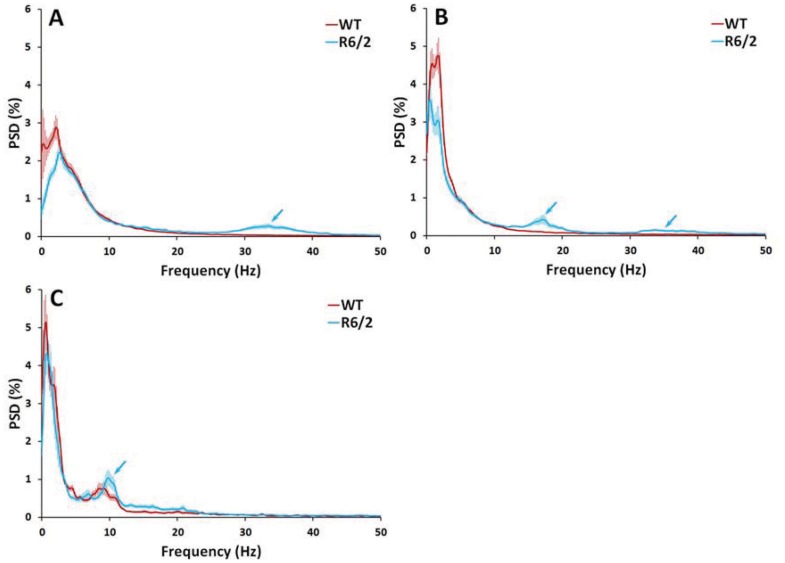
Striatal PSD across the different behaviors.Mean PSD curves obtained from striatal LFPs are denoted as a proportion of total power (% PSD) for WT (red) and R6/2 mice (blue) across quiet rest (A), grooming (B), and exploration (C). Error bars denote SEM around the group mean % PSD at each frequency. Arrows mark the higher frequency peaks in the R6/2 mice during resting and grooming as well as the 8–12 Hz theta band activity in both WT and R6/2 mice during exploration.